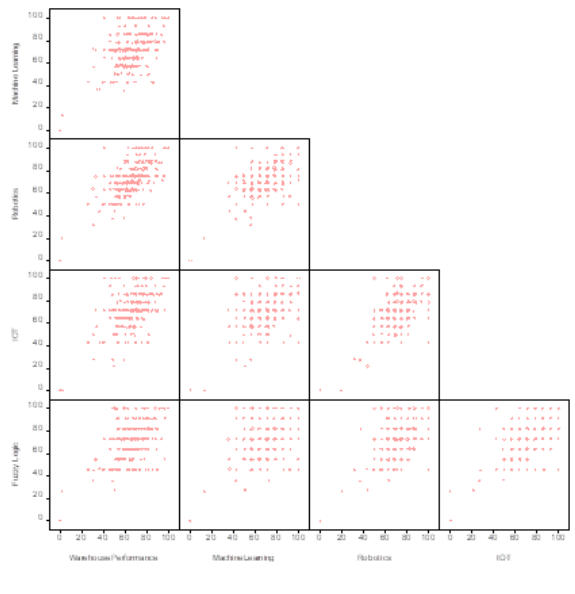
Source : Sample survey,